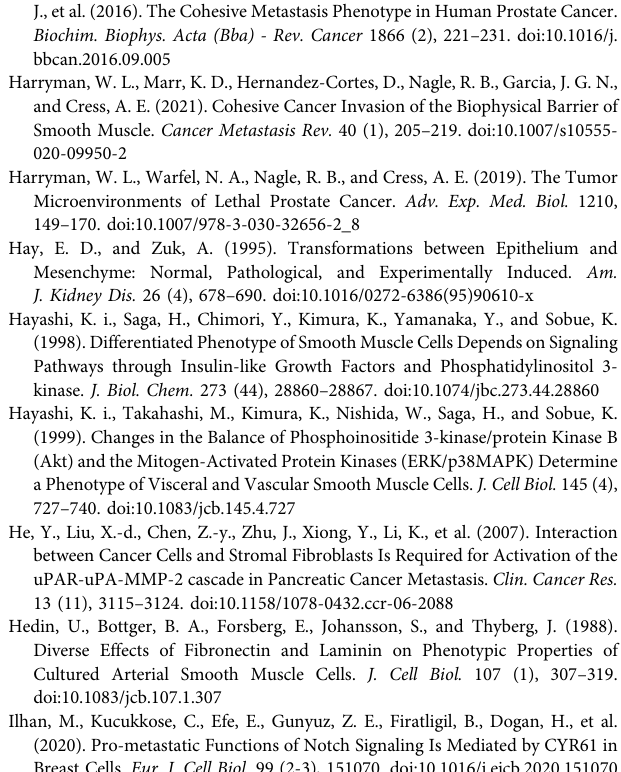
(2020). Pro-metastatic Functions of Notch Signaling Is Mediated by CYR61 in Breast Cells. Eur. J. Cell Biol. 99 (2-3), 151070. doi:10.1016/j.ejcb.2020.151070